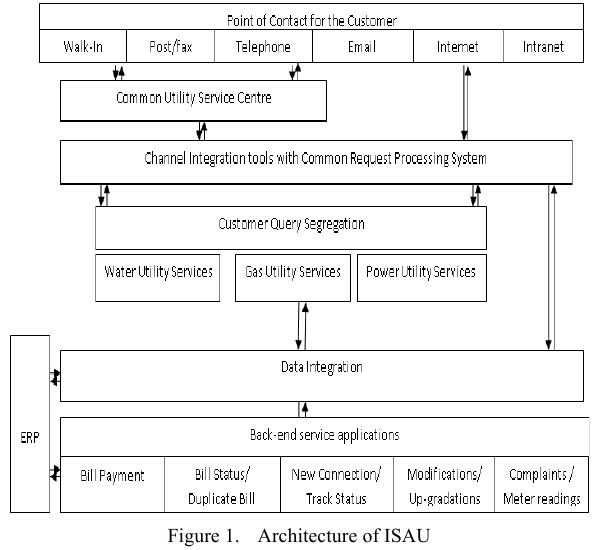
Figure 1. Architecture of